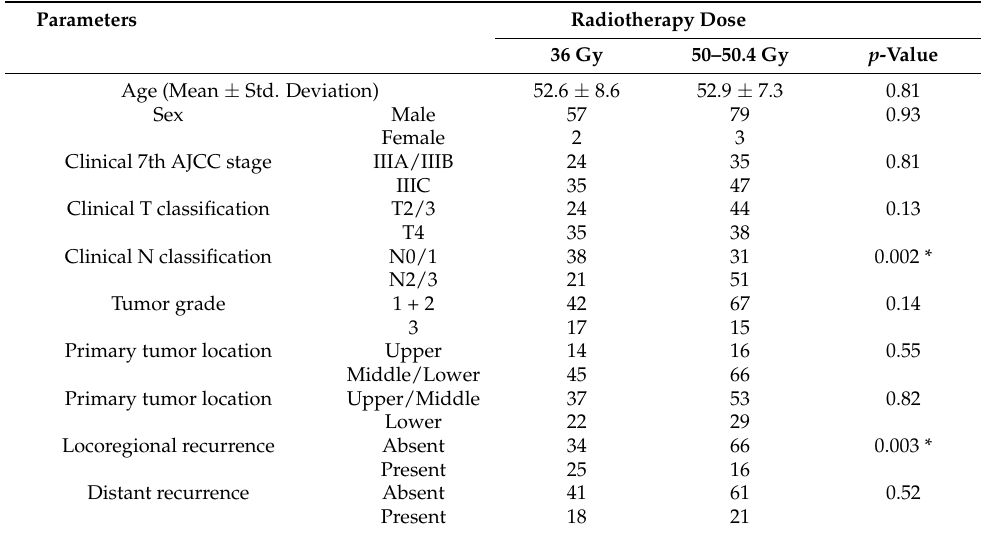
Table 2. Associations between radiotherapy dose and clinicopathologic parameters in 141 patients